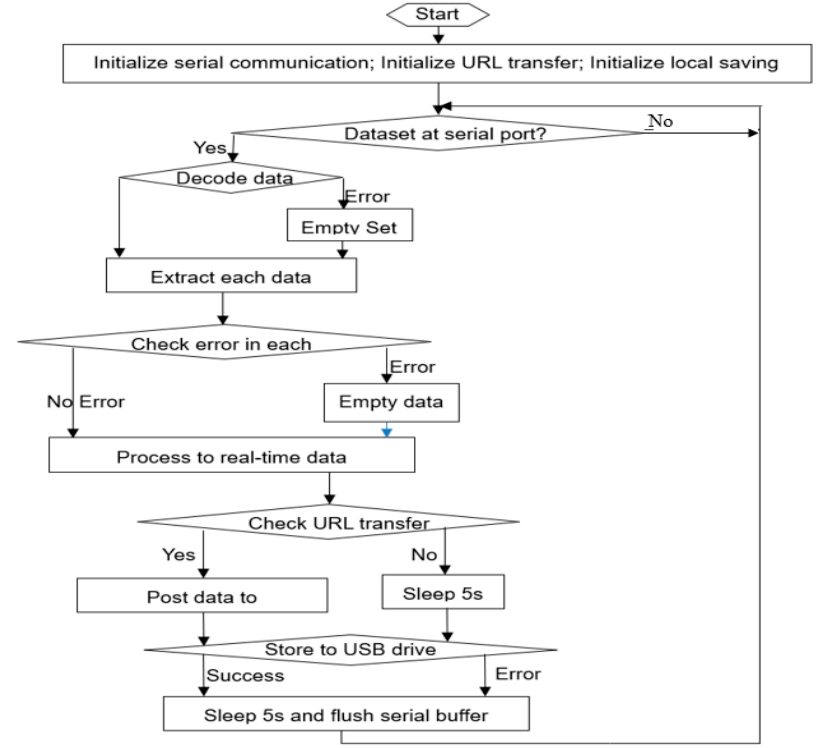
Figure 15. Flow chart of python program.